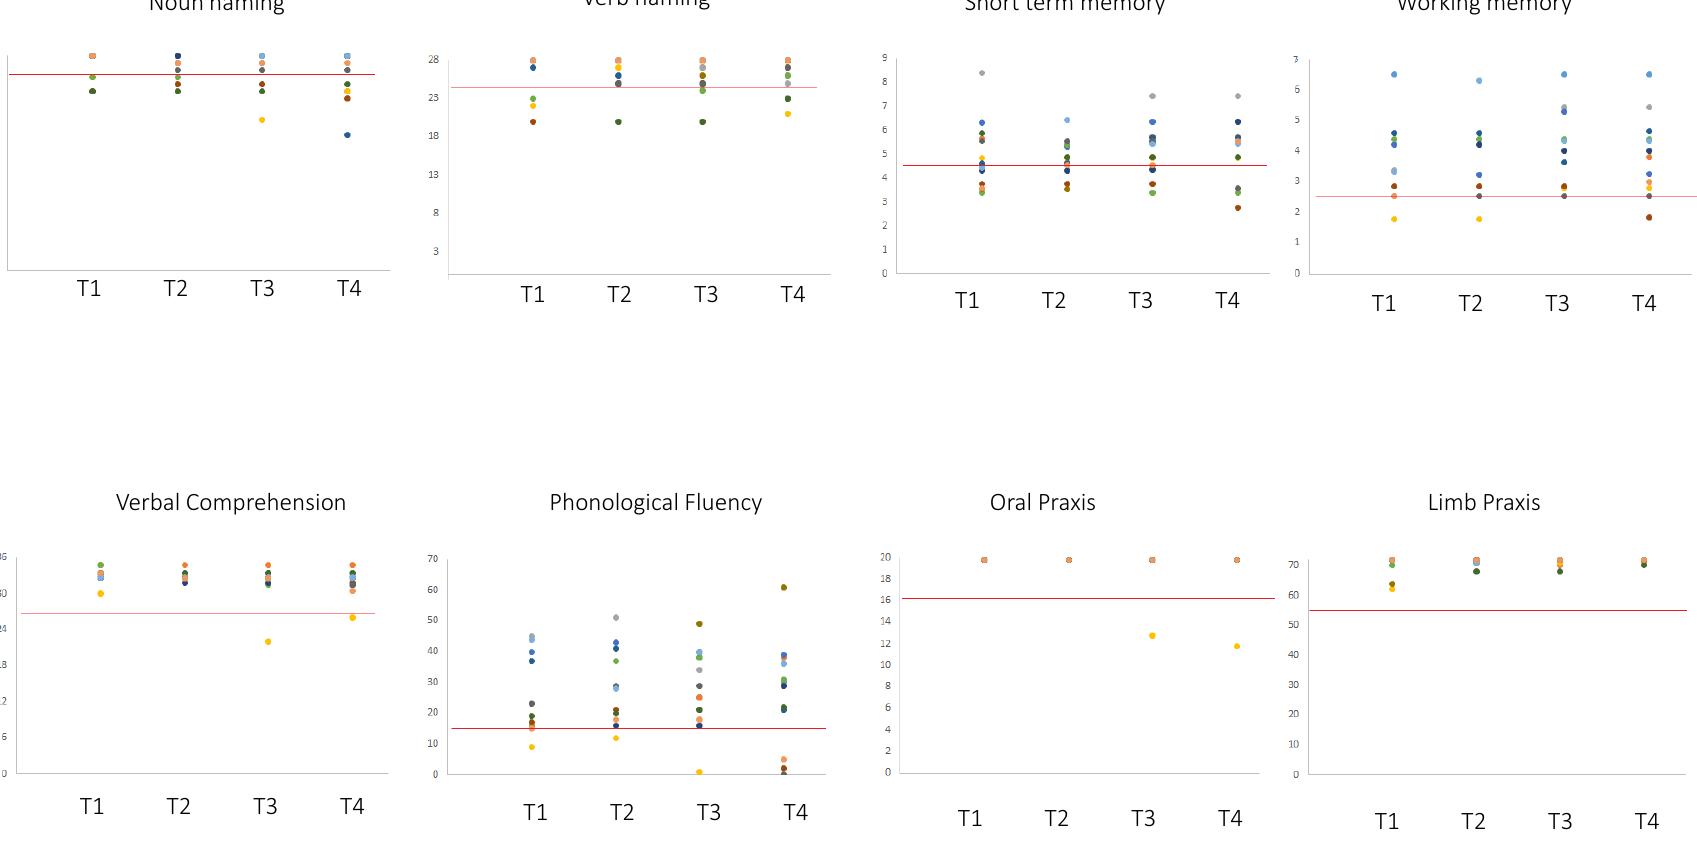
Figure 5. Performance of the 17 patients with recurrent glioma at T1 and T2 (pre- and post-first surgery, respectively) and at T3 and T4 (pre- and post-recurrence surgery, respectively). Red lines indicate the cut-o ff , below which the patient results are pathological ( < 4.26 is equal to an equivalent score of 0) [30,31], working memory ( < 2.65 is equal to an equivalent score of 0) [30], ideomotor limb apraxia ( < 53) [25] and oral apraxia ( < 16) [26], language comprehension ( < 26.25 is equal to an equivalent score of 0) [27], object naming and action naming ( < 28 and < 26 respectively) [28] and verbal fluency ( < 16 is equal to an equivalent score of 0) [29]. Patients showing identical scores are represented by overlapping